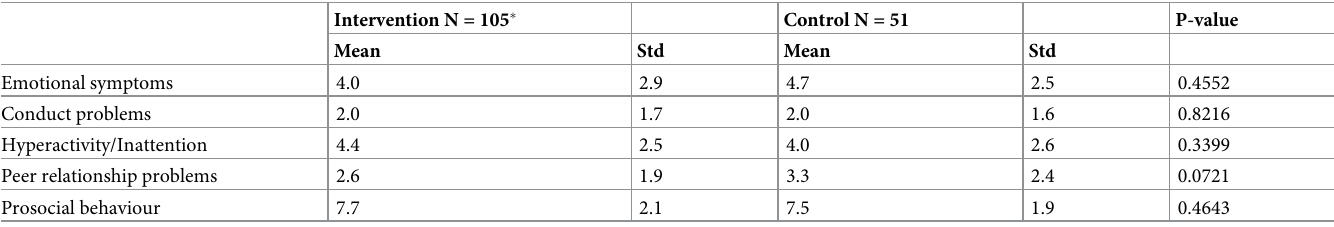
Table 4. Mean and standard deviation for the five scales in the SDQ. The regression models are adjusted for age and